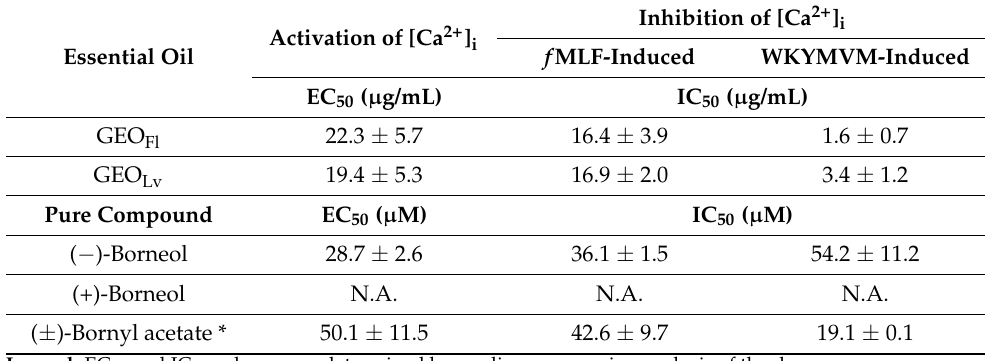
Legend : EC 50 and IC 50 values were determined by nonlinear regression analysis of the dose–response curves as described under Section 2. For cytotoxicity study, human neutrophils were incubated with indicated concentra- tions of the compounds for 90 min, and cell viability was analyzed. N.A. indicates the samples had essentially no activity (EC 50 or IC 50 >55 µ M for pure compounds or >55 µ g/mL for the oils). The data are presented as the mean ± SD of three independent experiments. * reported in [59].